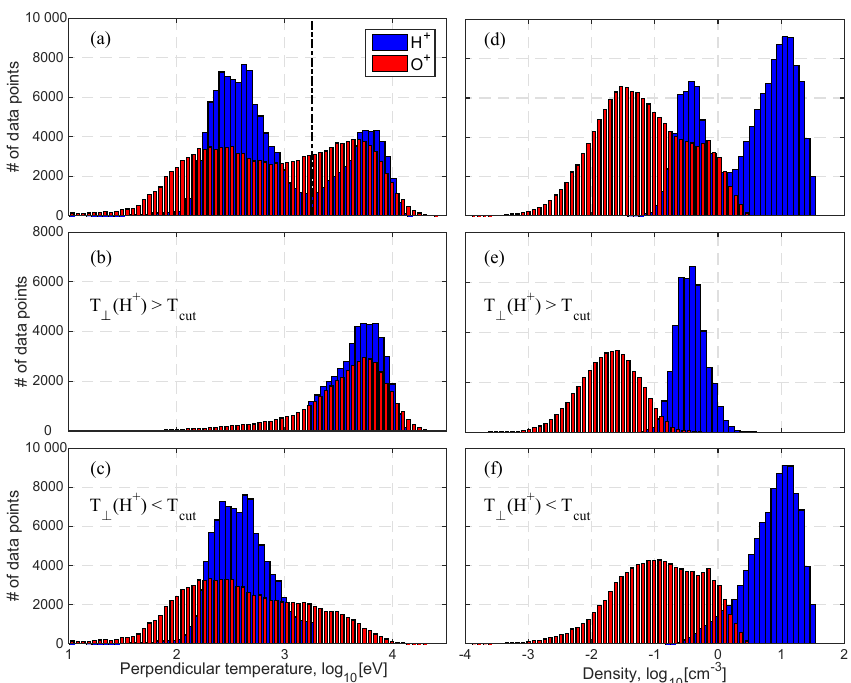
Figure 3. Distributions of β > 0 . 1 data in the dayside magnetosphere, covering 2001–2005. The left and right panels represent H + and O + temperatures and number densities respectively. The top panels (a, d) show all data, whereas the middle panels (b, e) show the data subset corresponding to H + T ⊥ higher than T cut = 1750eV, marked with a vertical line in (a) . The lower panels show the data subset corresponding to H + T ⊥ lower than T cut